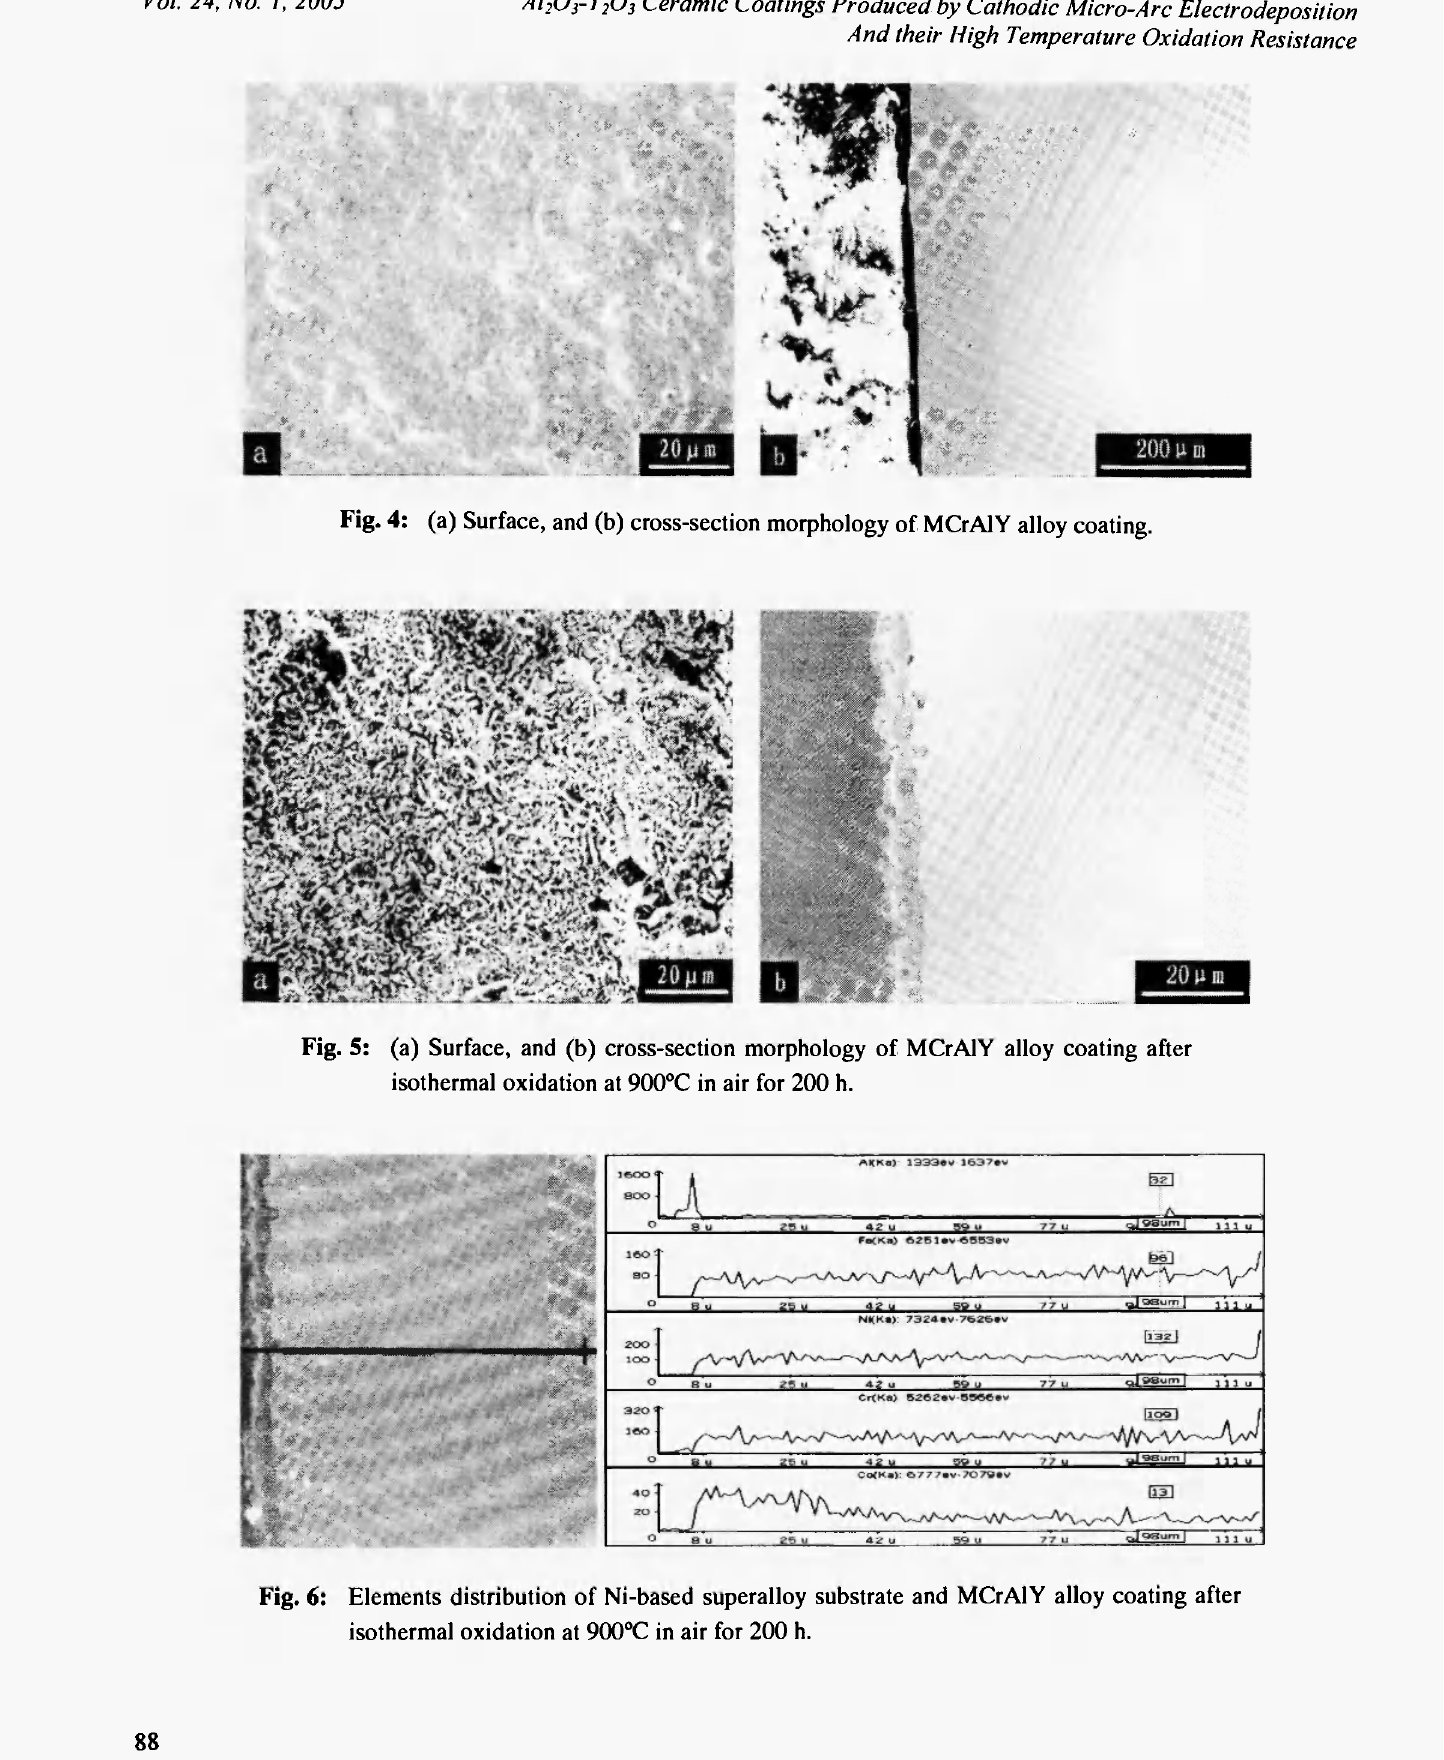
Fig. 6: Elements distribution of Ni-based superalloy substrate and MCrAlY alloy coating after isothermal oxidation at 900°C in air for 200